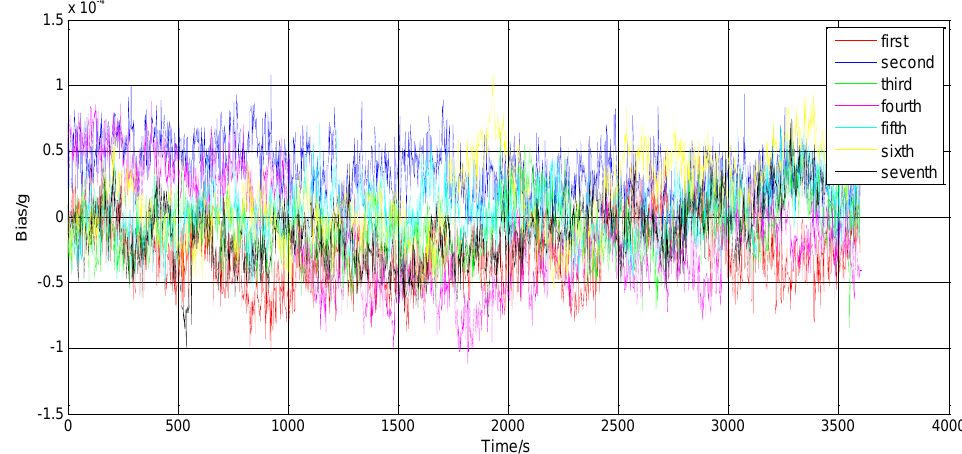
Figure 11. Measured bias (magnified seven times) versus the elapsed time.